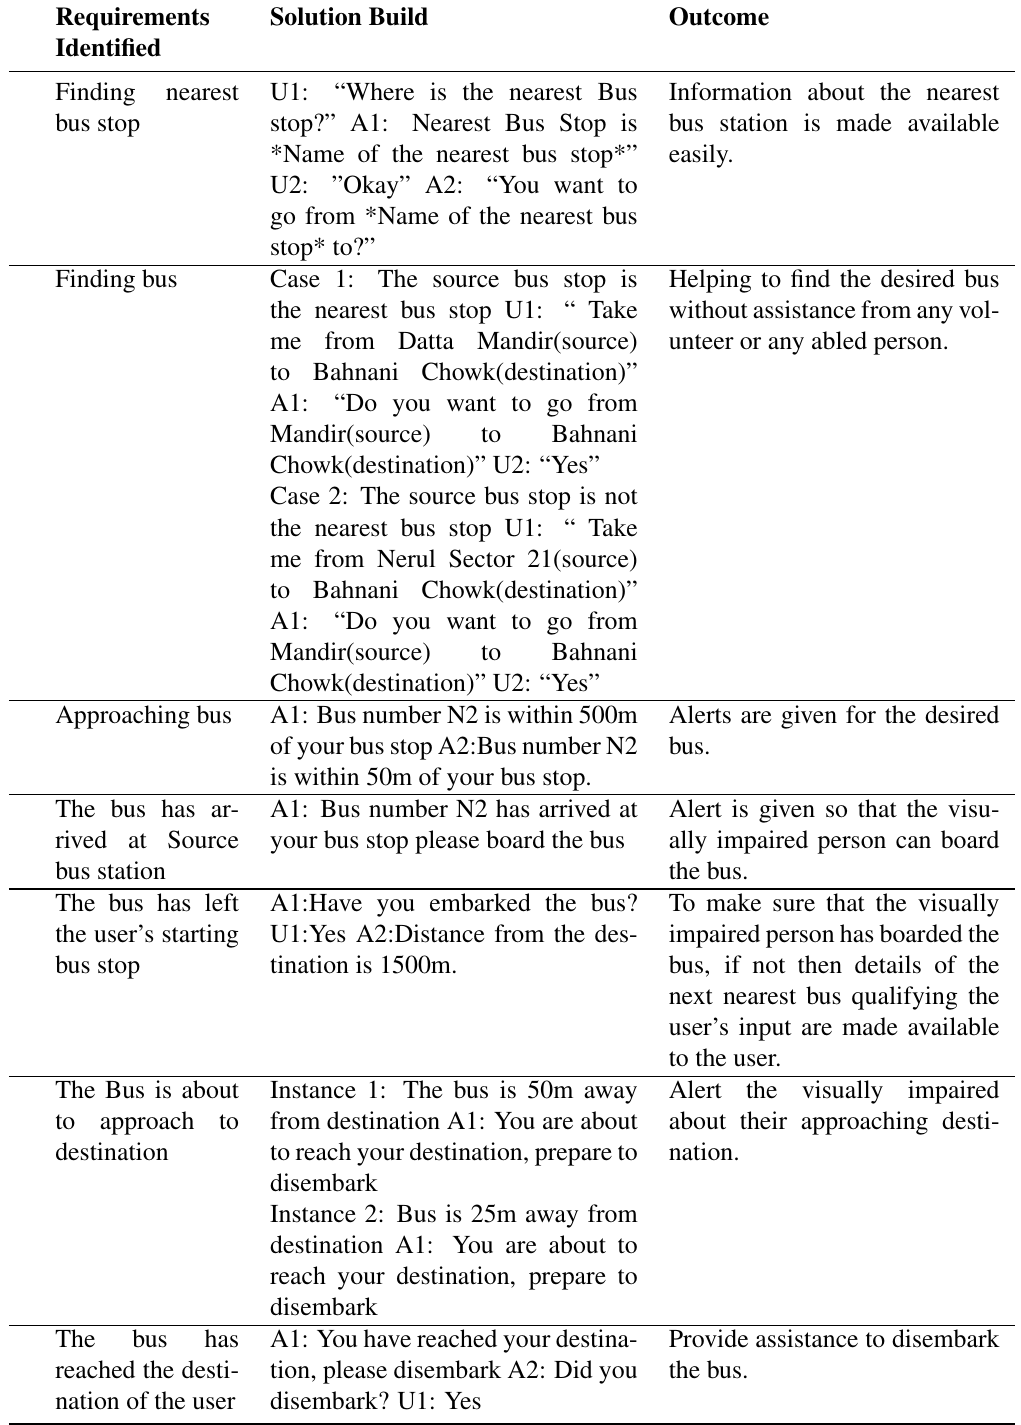
Table 1: Table of solutions and